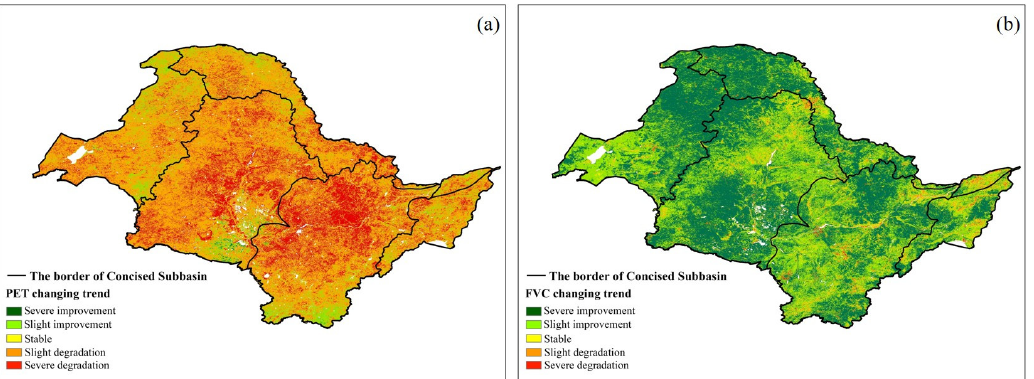
Figure 8. Changing trend of ( a ) potential evapotranspiration (PET) and ( b ) fractional vegetation coverage (FVC), 2001–2019 in the basin. coverage (FVC), 2001–2019 in the